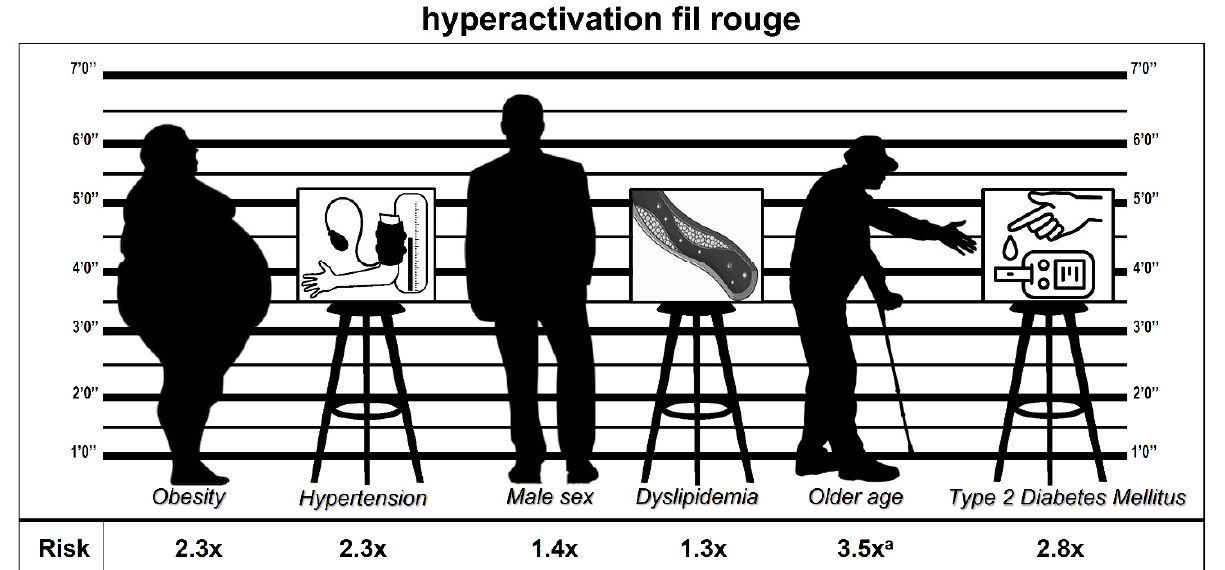
Figure 2. Identikit of the patient at risk for severe COVID-19: “classic RAS” inappropriate activation in a context of lower ACE2 activity as a common feature. Health conditions, cardiometabolic comorbidities, and their assumed relative risk [5,25,43,85,107,117]. a: for patients aged ≥ 75 years.